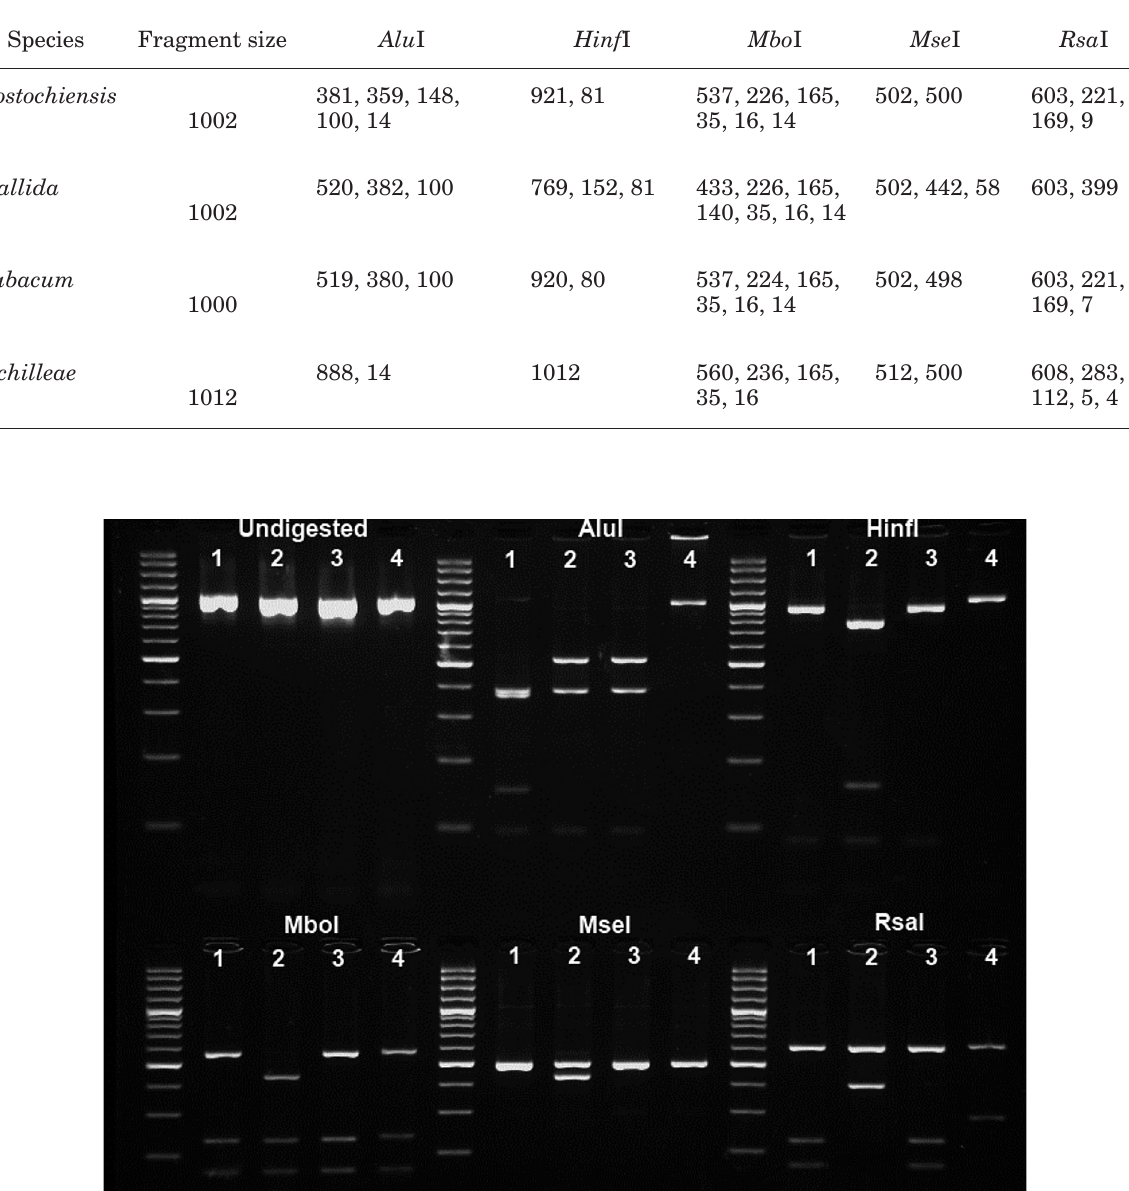
Table 3. Length of rDNA amplified fragments and fragment length after digestion with five restriction enzymes of four Globodera species ( Globodera rostochiensis, G. pallida, G. tabacum and G. achilleae ).